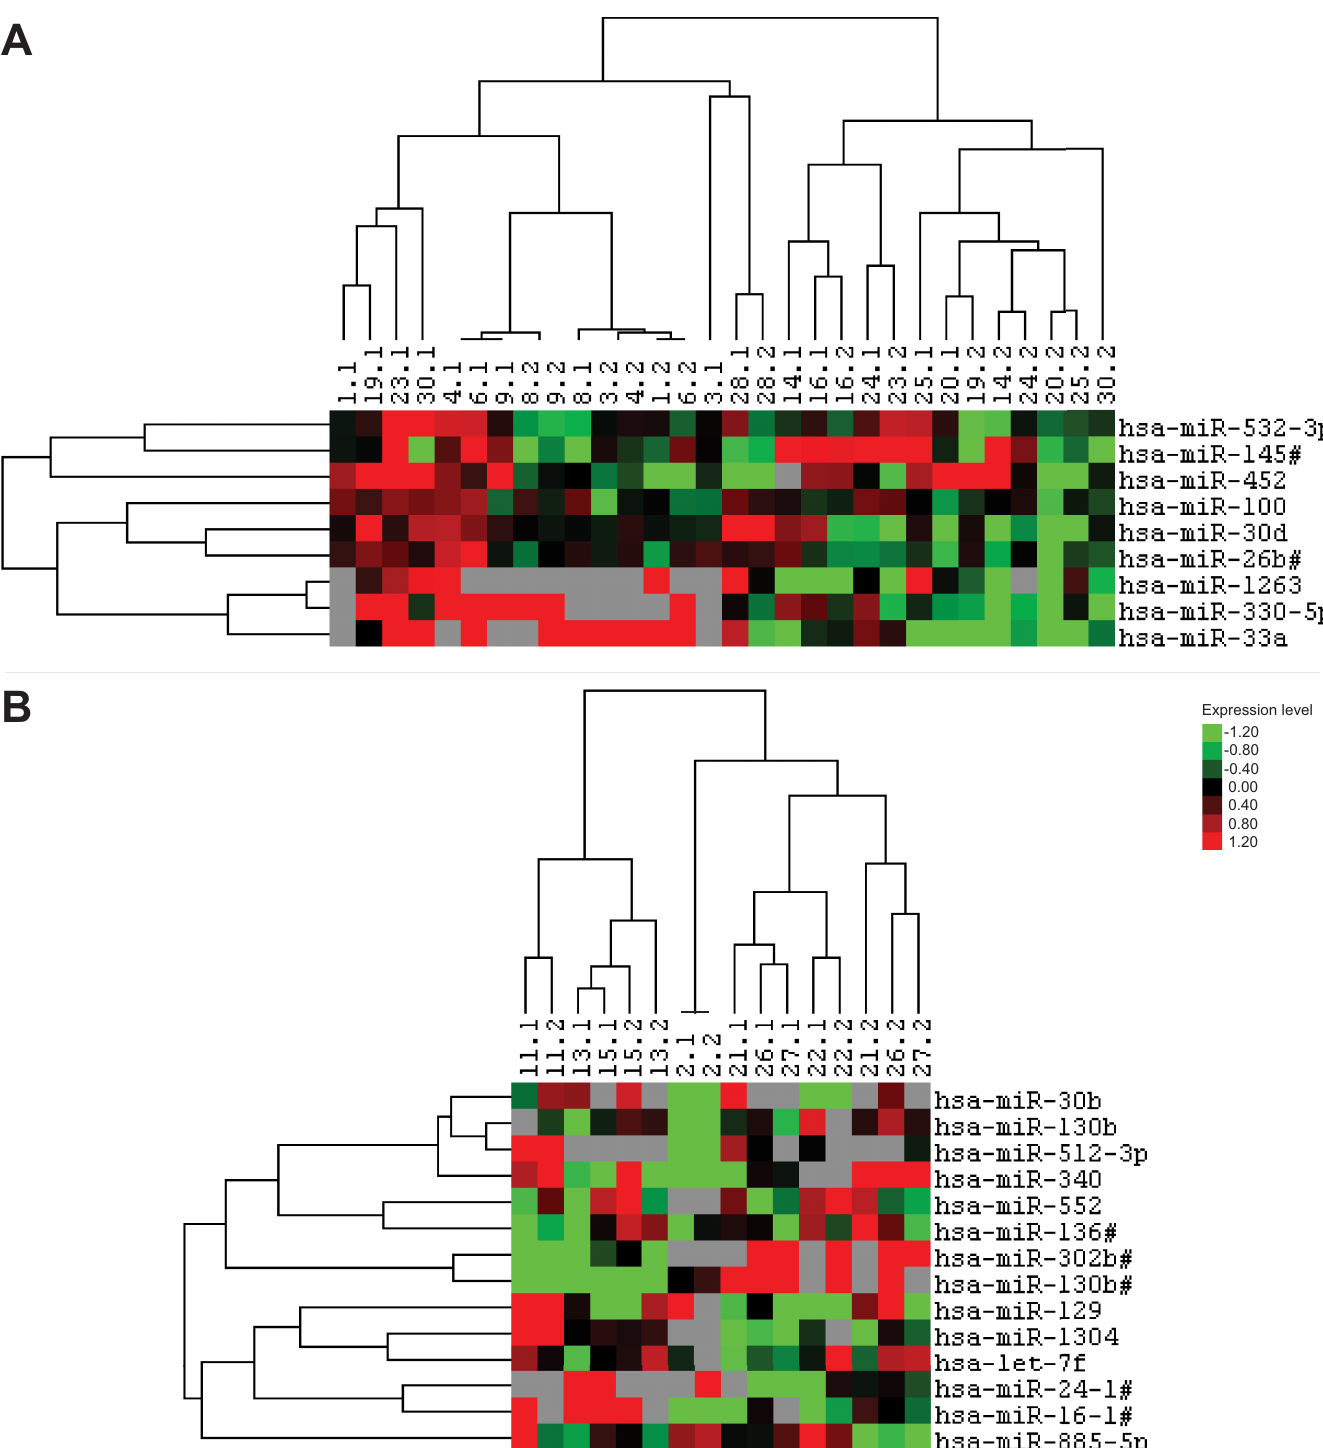
Fig 2. Hierarchical clustering based on the microRNA expression levels of paired primary and recurrent WDLPS tumor samples of the two main tumor localizations. Grey designates missing expression values. ( A ) Results of a supervised clustering analysis based on nine differentially expressed microRNAs (p < 0.05, FDR < 0.25; N = 15 pairs) between primary and recurrent WDLPS of the extremity. ( B ) Results of a supervised clustering analysis based on 14 differentially expressed microRNAs (p < 0.05; N = 8 pairs) between primary and recurrent WDLPS of the retroperitoneum.